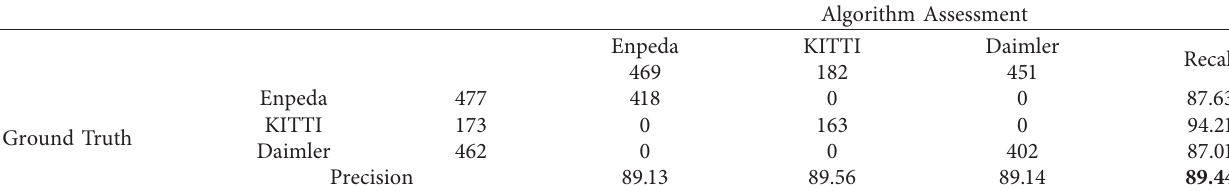
Table 2: The vehicle detection result mixing matrix of three standard